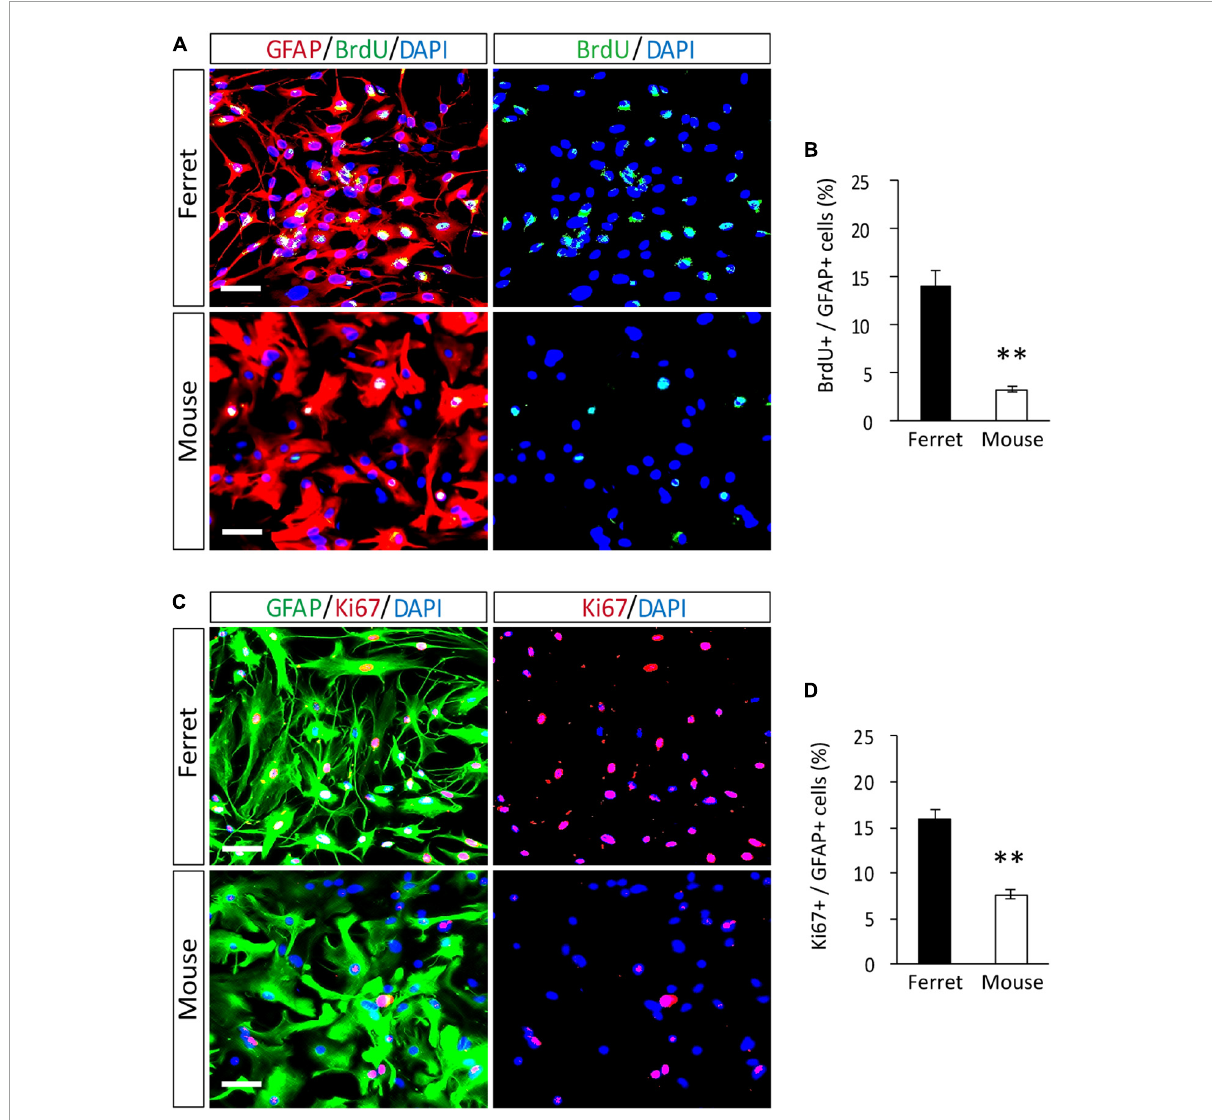
FIGURE4 Proliferation of ferret and mouse astrocytes. (A–D) Ferret and mouse astrocytes cultured with serum for 4 days were subjected to immunocytochemistry with antibodies against GFAP, BrdU, and Ki67. Nuclei were counterstained with DAPI. Scale bars = 50 µ m. (B,D) Proportion of BrdU- or Ki67-positive cells in GFAP-positive astrocytes. n = 5 independent cultures. Data represent the means ± SEM. The P -values were determined using paired Student’s t -test. ∗∗ P <